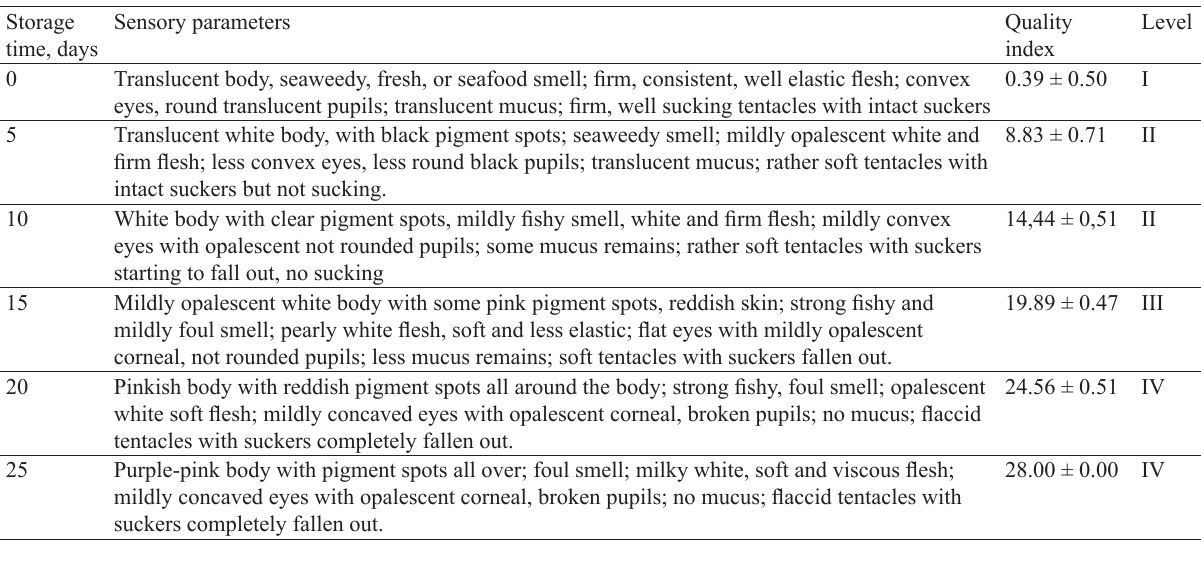
Table 2 Changes in sensory parameters of Uroteuthis (Photololigo) chinensis L. during ice storage Storage